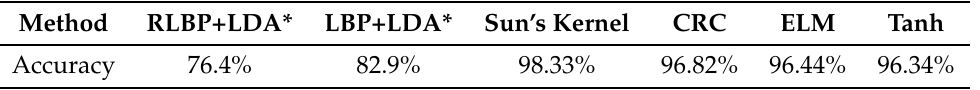
Table 7. Accuracy of our RLBP+LDA and LBP+LDA methods compared to other face classification algorithms discussed in [83], using the Yale face database B [82].